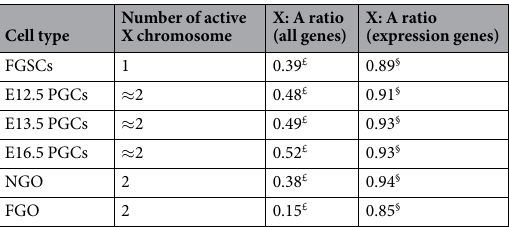
Table 1. The median X: A expression ratio in female germ cells at the different stages. £ Means the X: A ratio is significant close to 0.5 compare to1 ( χ -squared test, p < 0.001), § means the X: A ratio is significant close to 1 compare to 0.5 ( χ -squared test, p <